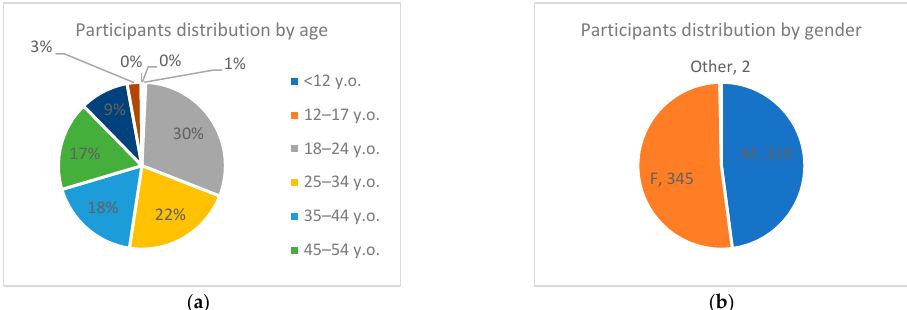
Figure 4. Demographic distribution of participants ( a ) by age and ( b ) by gender.